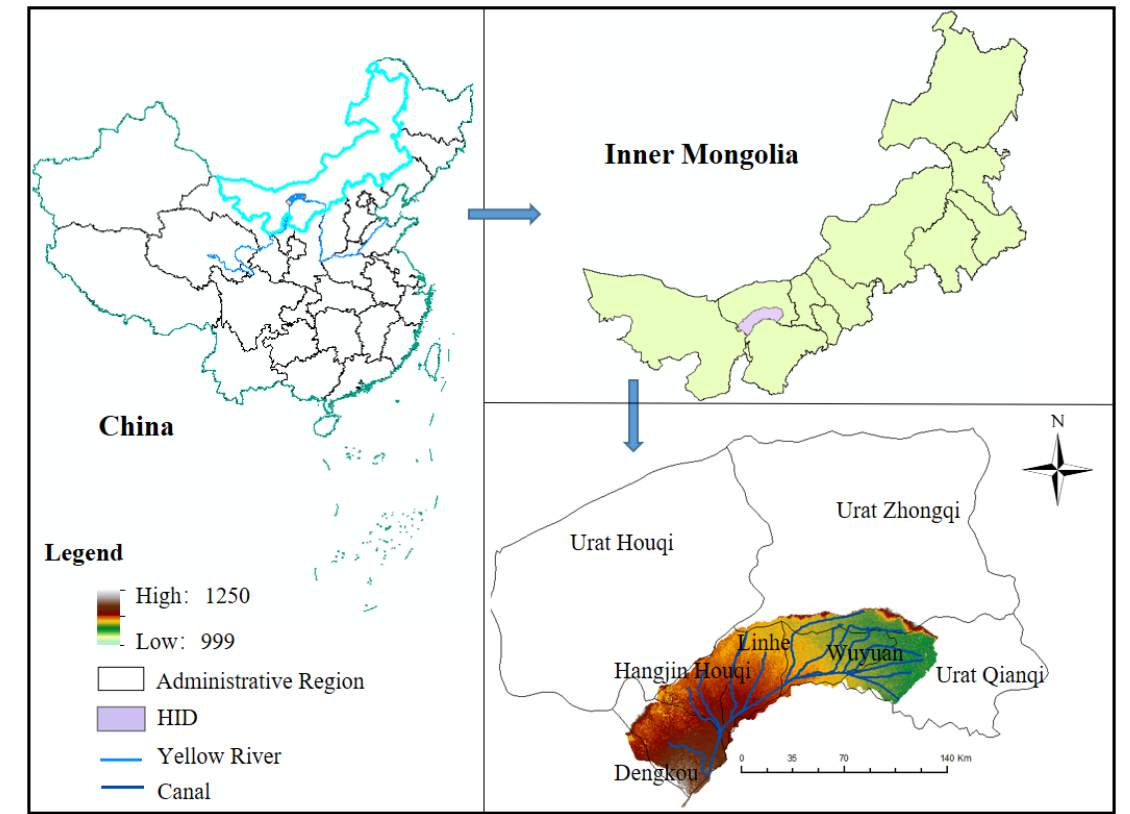
Figure 3. Study area location.